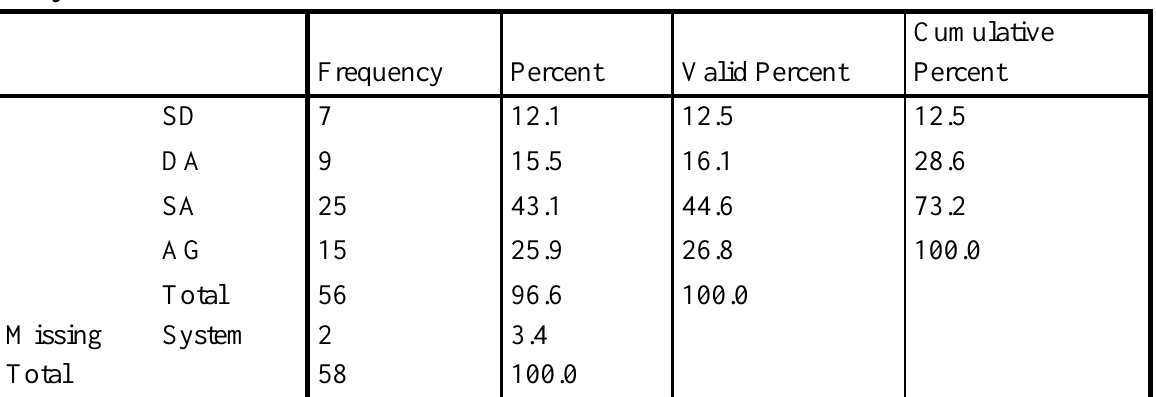
Your teachers can increase your inner motivation by employing different examples from daily